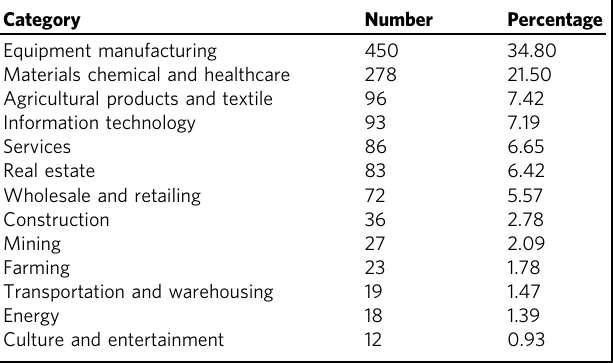
Table 1 Distribution of